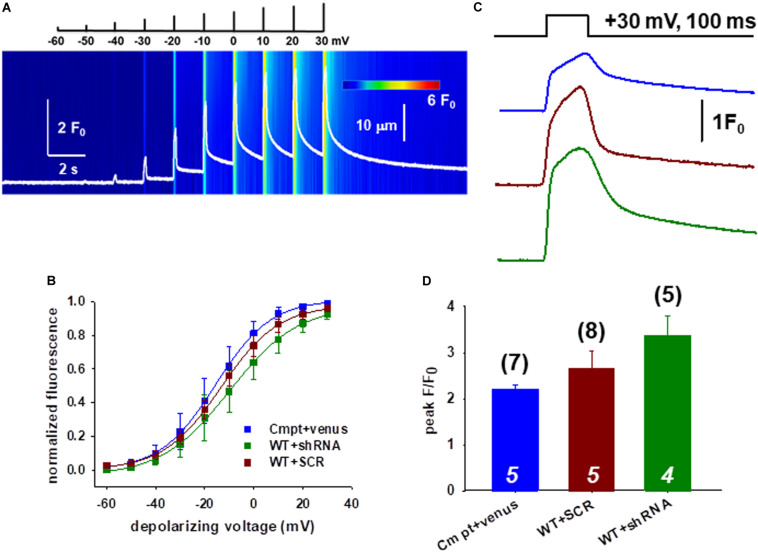
Slight changes of the release channel sensibility to voltage activation in FDB muscles following Orai1 manipulation. (A) Representative line-scan image of rhod-2 fluorescence normalized to the baseline value F0(x) in a WT fiber expressing the shRNA construct. The cells were held at –80 mV and were subjected to successive depolarizing voltage steps (top) under whole-cell patch-clamp. The pulses lasted 100 ms and the delay between two pulses was 1100 ms. The cells were perfused with 10 mM EGTA via the patch pipette. (B) Voltage dependence of the calcium transients. The normalized F/F0 values were fitted with a Boltzmann function (see Eq. 1 in section “Materials and Methods”) and then normalized to the obtained maximum. The continuous lines represent the best fit of the Boltzmann function to the average values with the best fit parameters given in Table 1. (C) Representative fluorescence intensity profiles plotted for peak F/F0 values obtained at maximal individual depolarizing pulses (+30 mV, 100 ms) for Cmpt fibers reconstructed with venus-Orai1 and the WT fibers transfected with SCR and shRNA-Orai1. (D) Pooled data for peak F/F0 values show no significant changes. The numbers in parenthesis denote the number of individual fibers whereas the numbers in italics denote the number of animals studied.